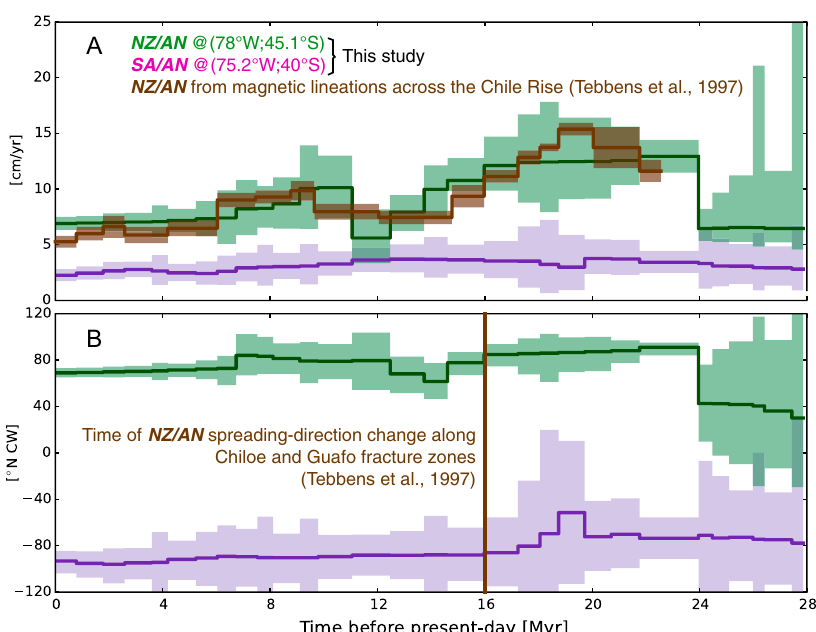
Fig. 4 Plate motions with respect to Antarctica. Rate ( A ) and azimuth ( B ) of motions of Nazca (NZ, green) and South American (SA, purple) plates relative to Antarctica (AN) plate, calculated at the speci fi ed coordinates. Motions are calculated by sampling one million times the fi nite rotations discussed in the main text. Uncertainty ranges are reported at the 95% con fi dence interval. The NZ/AN motion reconstructed here via the Paci fi c plate is compatible with the independent inference of changes in NZ/AN spreading rates and azimuth derived from observed cross-ridge magnetic lines as reported by Tebbens et al. (1997, in brown).